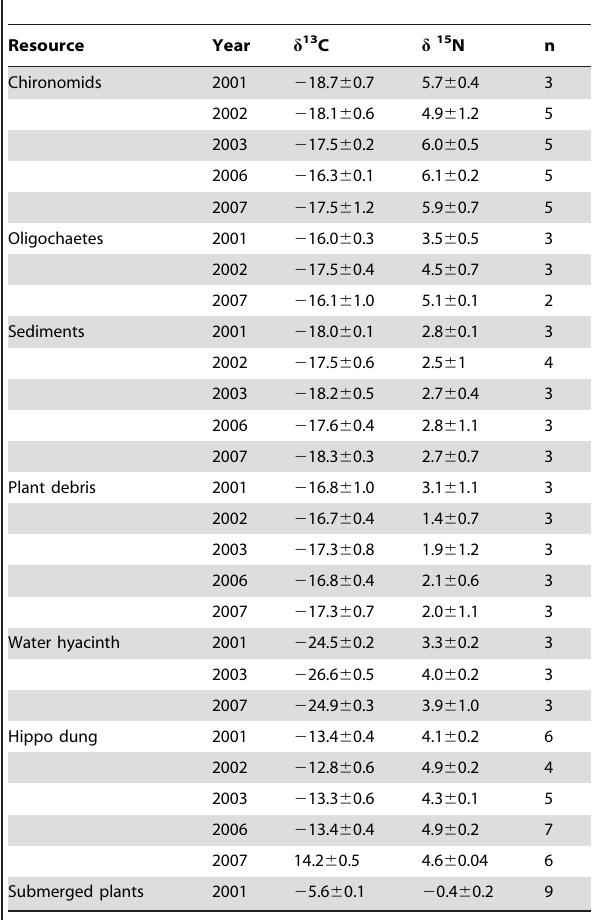
Table 1. d 13 C and d 15 N values for basal resources and dominant benthic primary